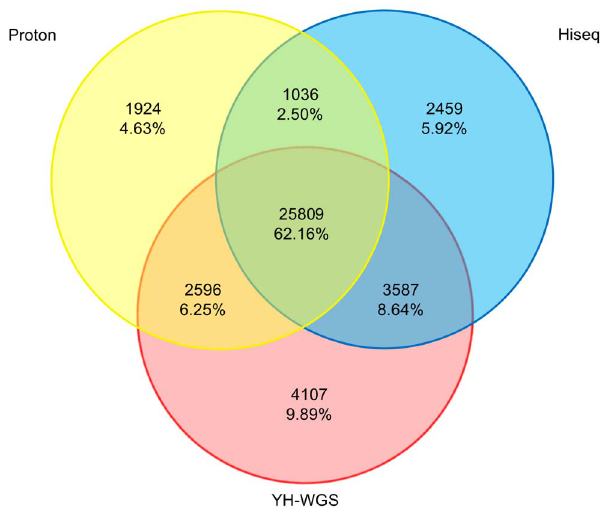
Figure 6. Venn diagram of the overlap in the numbers of variant calls using Proton and Hiseq.